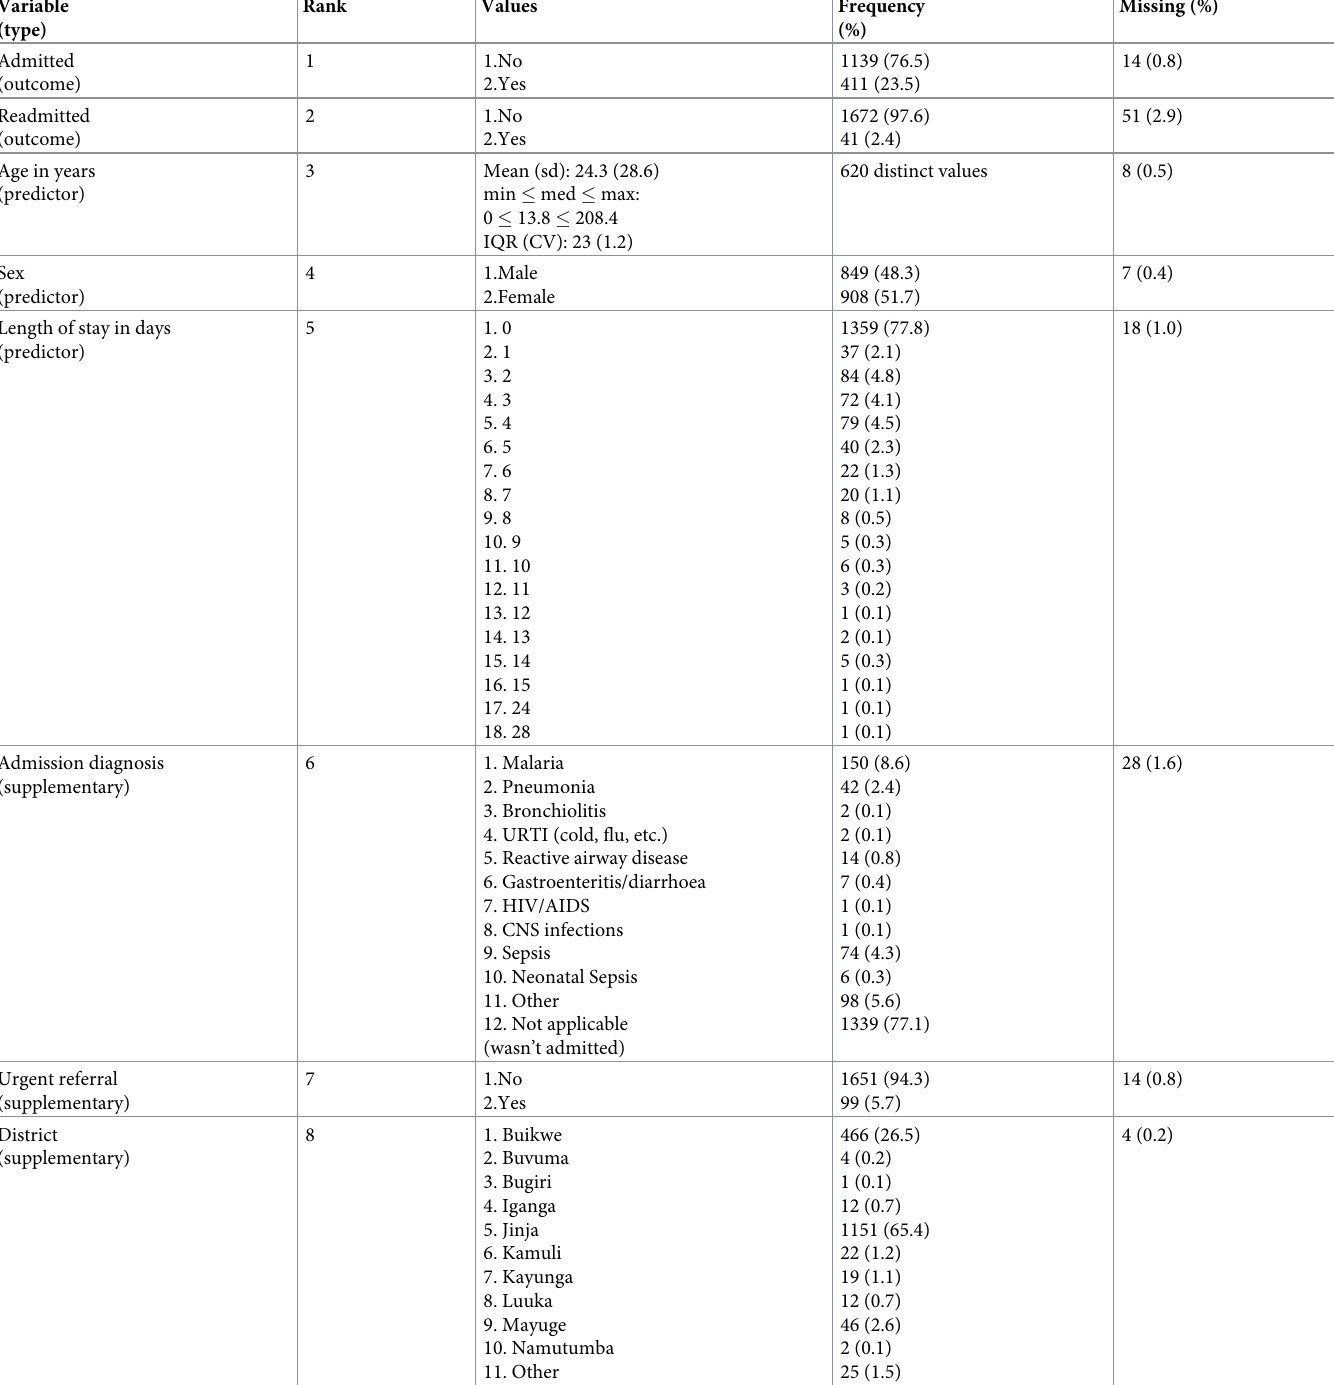
Table 4. Summary of quasi-identifiers requiring further